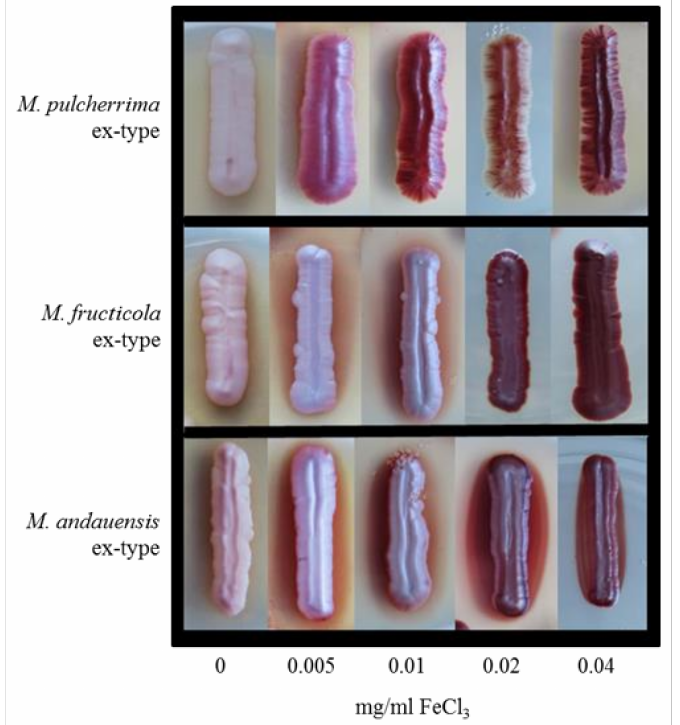
Figure 2. Effect of FeCl š concentration on pigmentation. The cultures shown are ex-types of M. pulcherrima CBS5833 T , M. fructicola CBS 8853 T , and M. andauensis CBS 10809 T , respectively. M. pulcherrima and M. sinensis formed darker colonies than the other strains at the lowest FeCl 3 concentration, but at 0.04 Mg/mL all cultures were equally pigmented. How- ever, the weaker colony pigmentation does not necessarily imply less efficient pulcherrimin synthesis. It can also be due to the formation of some of the pigment in the medium around the colonies (generating a pigmented halo). Upon prolonged incubation, less pigmented sectors appeared at the edges of all cultures (Figure 3). When isolated and inoculated onto fresh medium, these sectors (segregants) formed pale or pink cultures. As the pigment is the chelate of ferric irons and pulcherriminic acid [1], the reduced pigmentation implies that pulcherriminic acid was synthesised at a reduced rate in these segregants. The dark sectors formed dark colonies when inoculated onto fresh medium. However, neither of the segregants was stable; their colonies occasionally contained segments or spots differing from the rest of the colony in pigmentation intensity (Figure 3). Because of the instability of colony pigmentation and the pigmented halos around the colonies, the intensity of pulcherrimin production cannot be used as a distinctive taxonomic trait